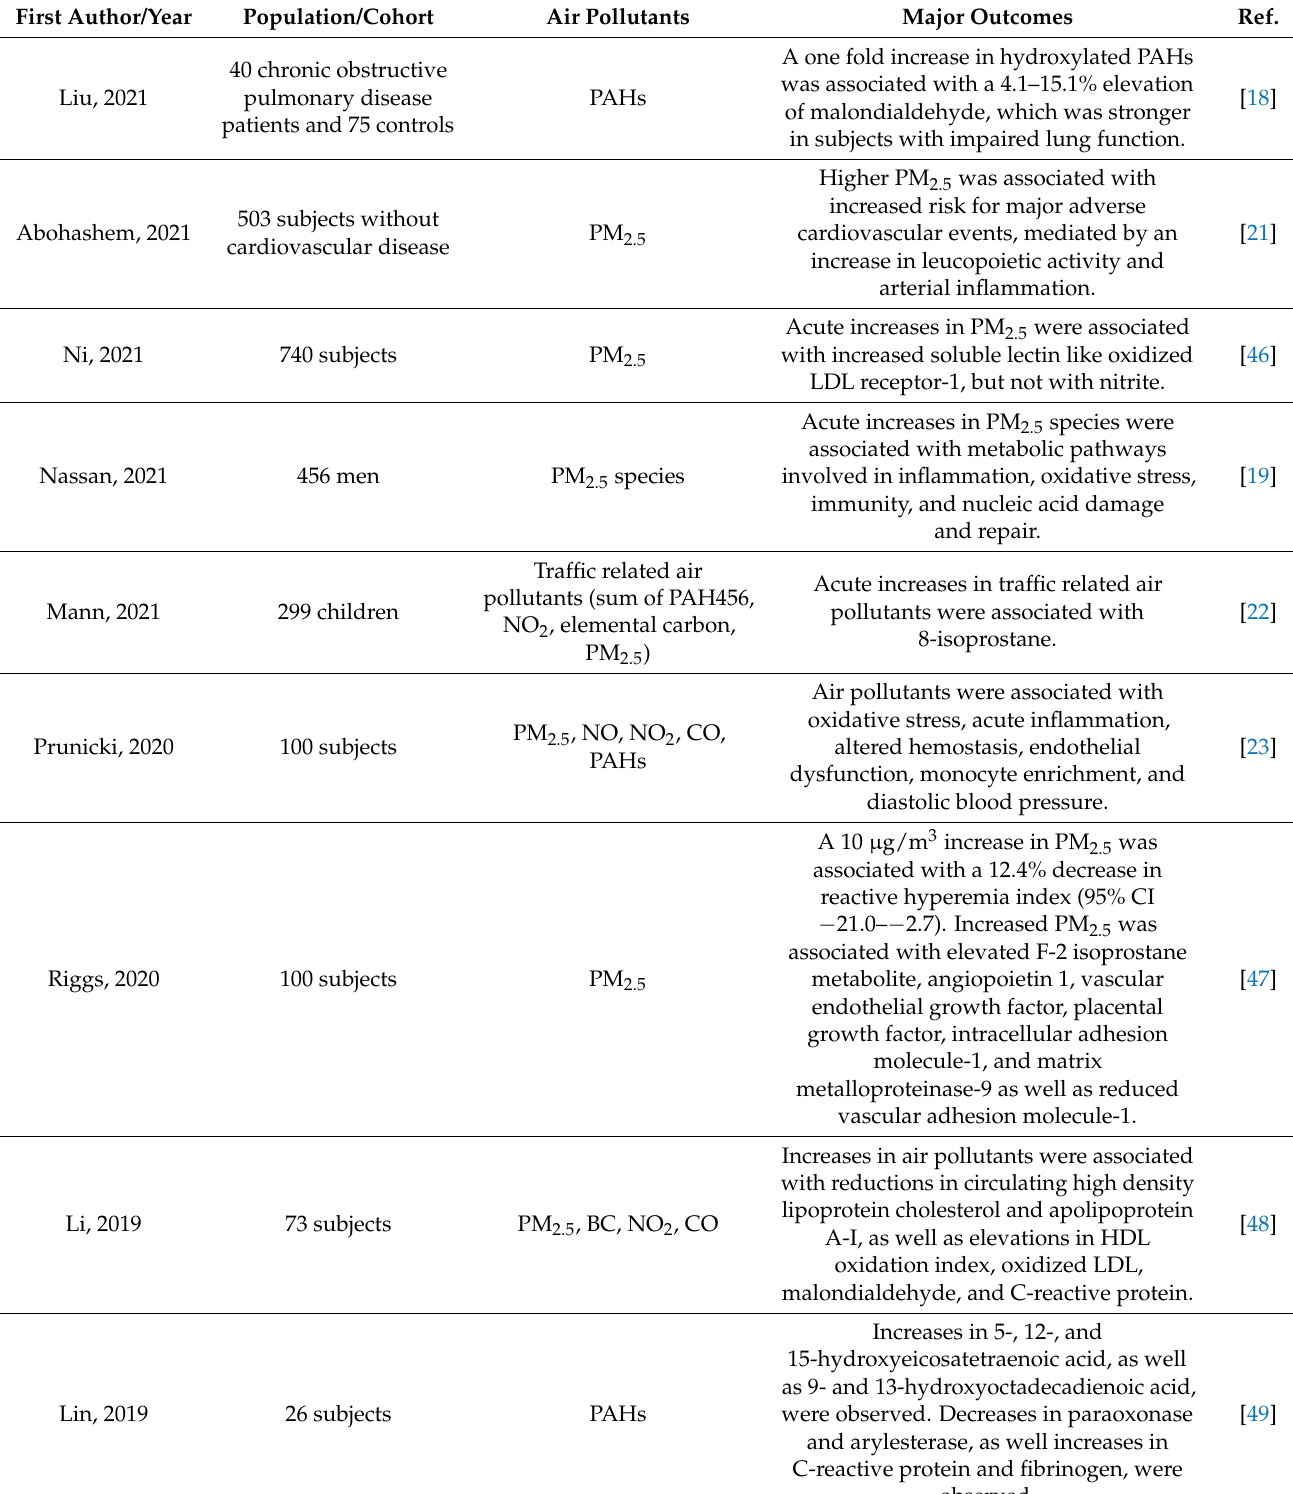
Table 1. Human studies on the association of inflammation and/or oxidative stress with air